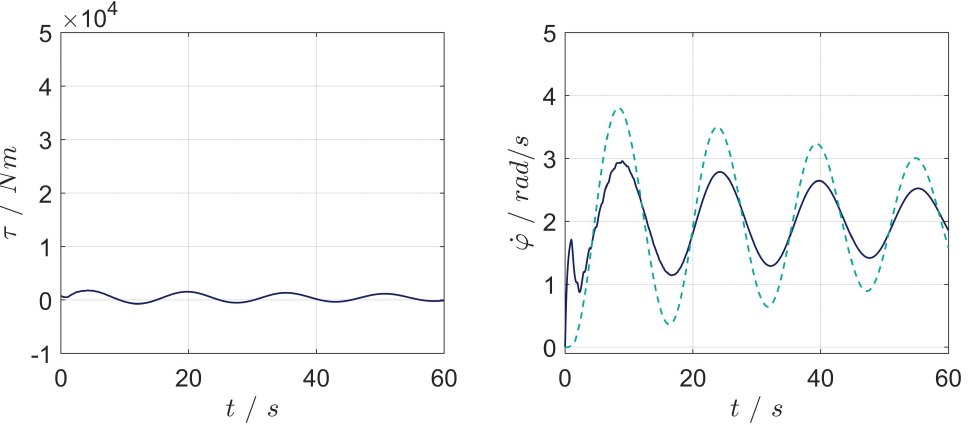
Figure 5. Step responses of the closed-loop nonlinear system applying velocity PI -controller with gain k P = 405: first mass ϕ 0 (solid blue) and second mass ϕ L (dotted green).